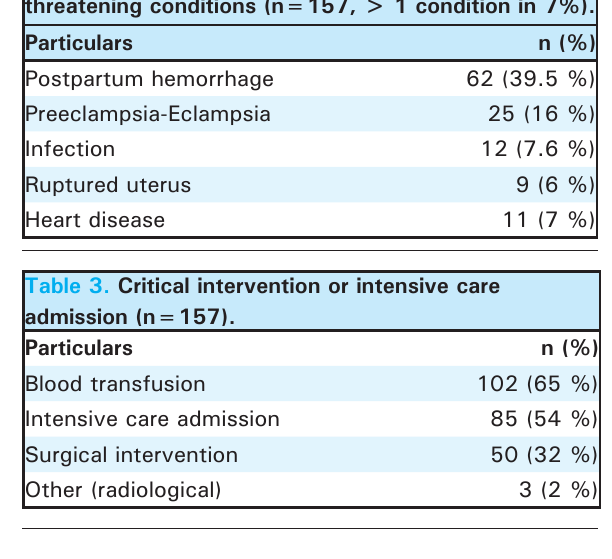
Table 2. Severe complication/ potentially life-